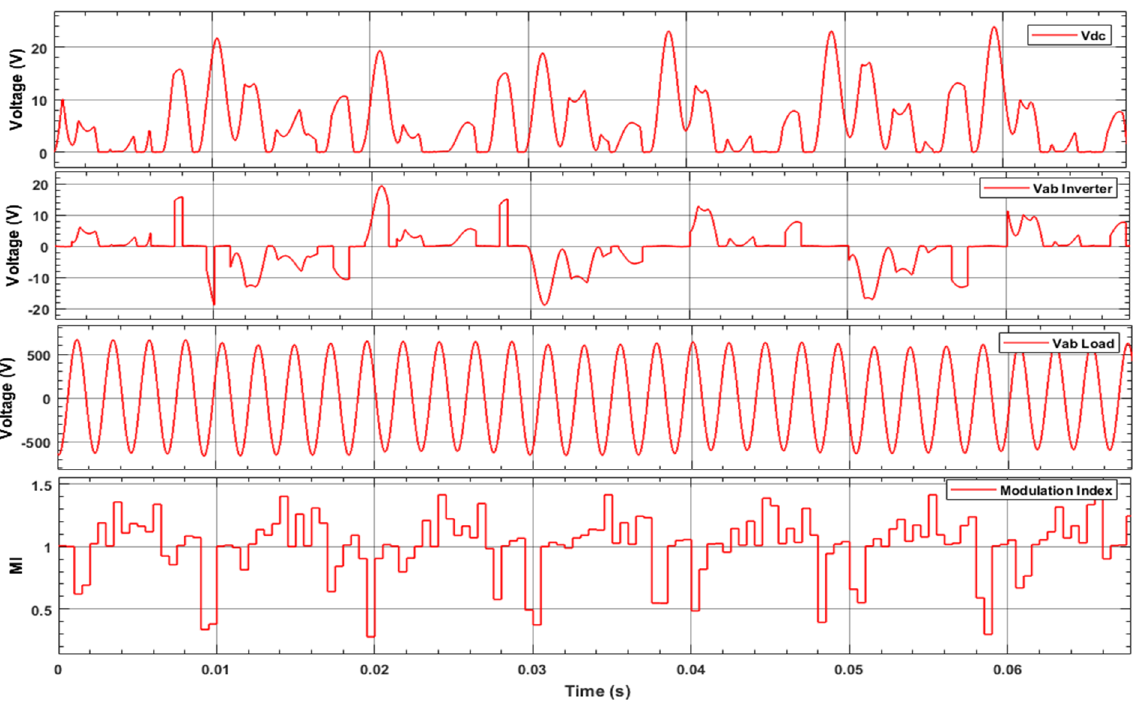
Figure 10. Inverter conditioning graphs.